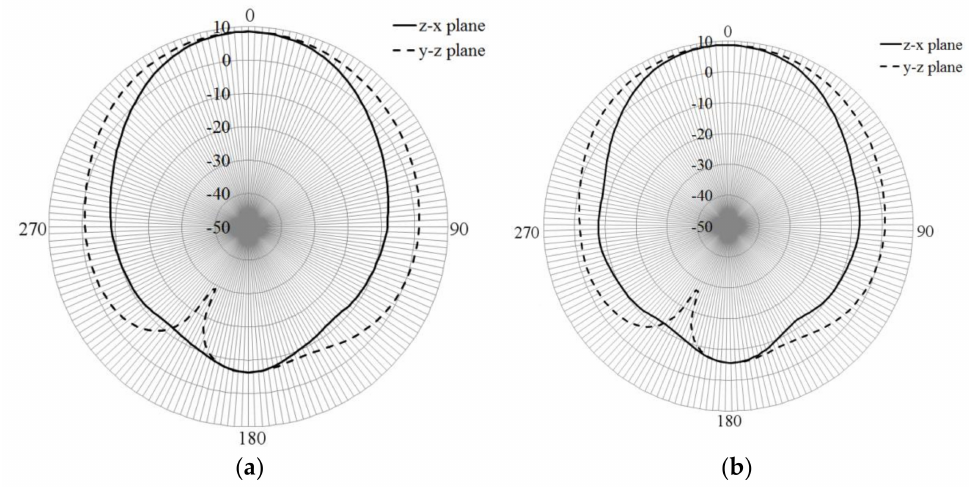
Figure 7. Simulated gain pattern of the dumbbell-shaped slot radiator with box reflector: ( a ) h1, ( b )